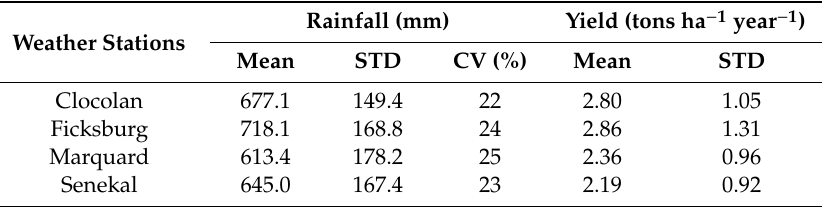
Table 1. The seasonal (October–March) rainfall characteristics of the Setsoto municipality between 1985 and 2019 across the